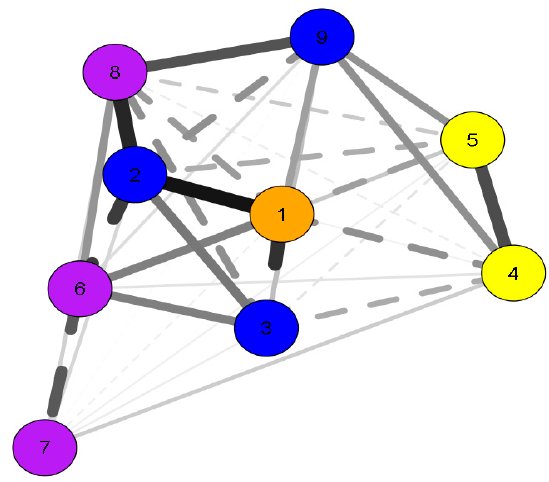
Figure 1. Network associations between compliance with screen time recommendation, sex, body mass index, fundamental motor skills, executive functions, and age. Orange node = compliance with screen time recommendation; blue nodes = anagraphics and anthropometrics; yellow nodes = fundamental motor skills; purple nodes = executive function trials; 1 = compliance with screen time recommendation; 2 = sex; 3 = body mass index; 4 = locomotion score; 5 = object control score; 6 = accuracy of Go; 7 = reaction time of Go; 8 = accuracy of No Go; 9 = age.